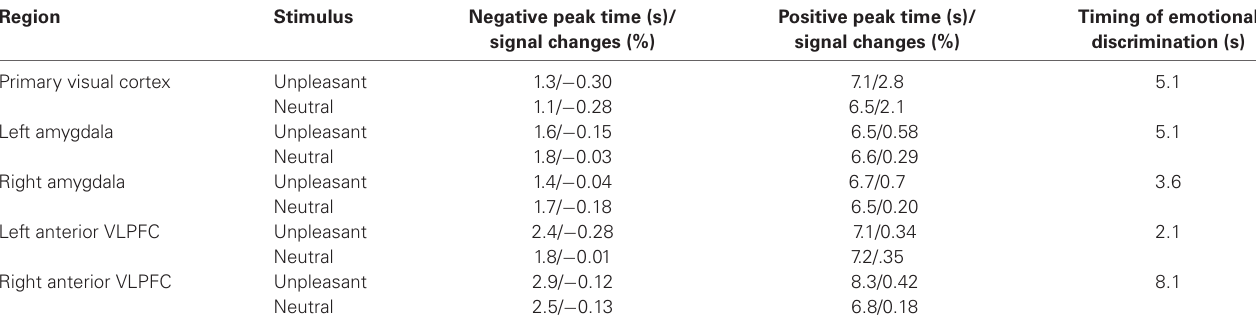
Table 1 | Timing of emotional discrimination in bilateral VLPFCs, bilateral amygdalae and the primary visual cortex .